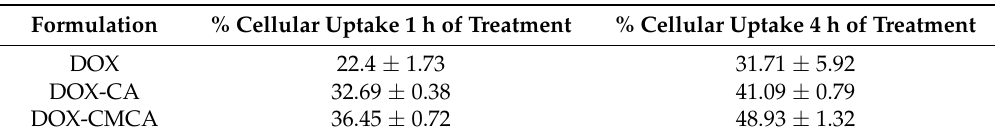
Figure 8. Cellular uptake of free DOX, DOX-CA NPs and DOX-CMCA NPs. ( A ) fluorescence intensity measuring DOX (1 µM) uptake with MCF-7 cells at 1 h of treatment; ( B ) fluorescence intensity measuring DOX (5 µM) uptake with MCF-7 cells at 1 h of treatment; ( C ) fluorescence intensity measuring DOX (1 µM) uptake with MCF-7 cells at 4 h of treatment; ( D ) fluorescence intensity measuring DOX (5 µM) uptake with MCF-7 cells at 4 h of treatment. Values were significant (*) at p -value < 0.05, extremely significant (**) at p -value < 0.0001 vs. untreated cells at CI of 95%. Table 4. Cellular uptake for DOX 1 µM, DOX (1 µM)–CA NPs and DOX (1 µM)–CMCA NPs after 1 h and 4 h of treatment.